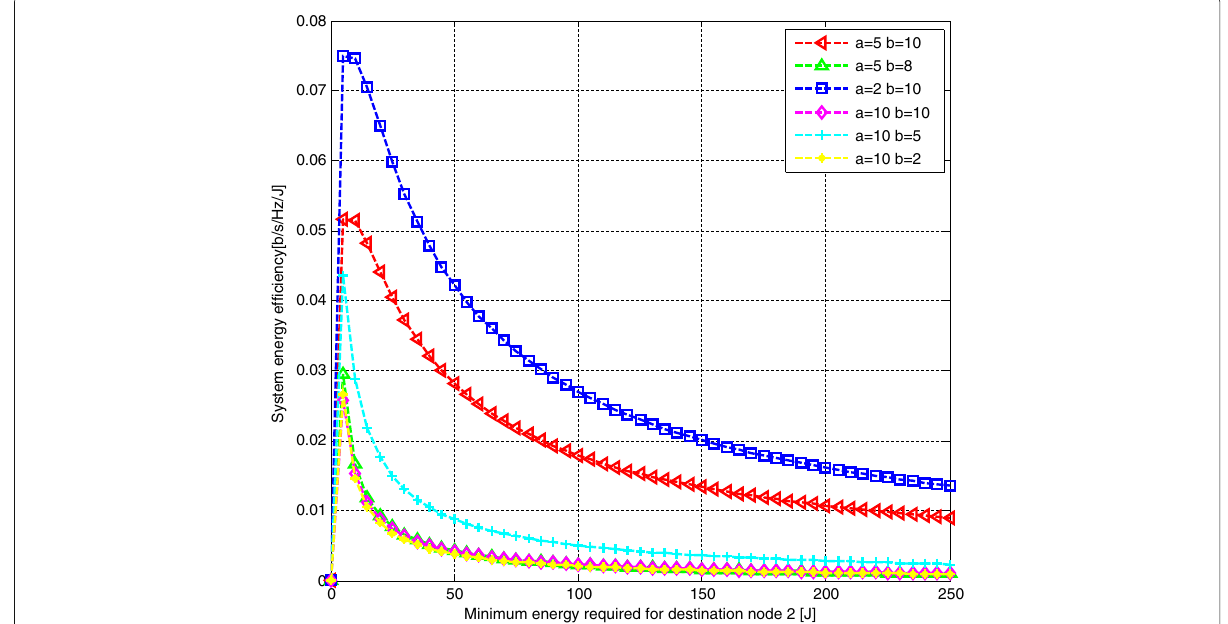
Fig. 2 Achieved energy efficiency of the whole IoT systems by the proposed scheme at the power splitting factor ρ =